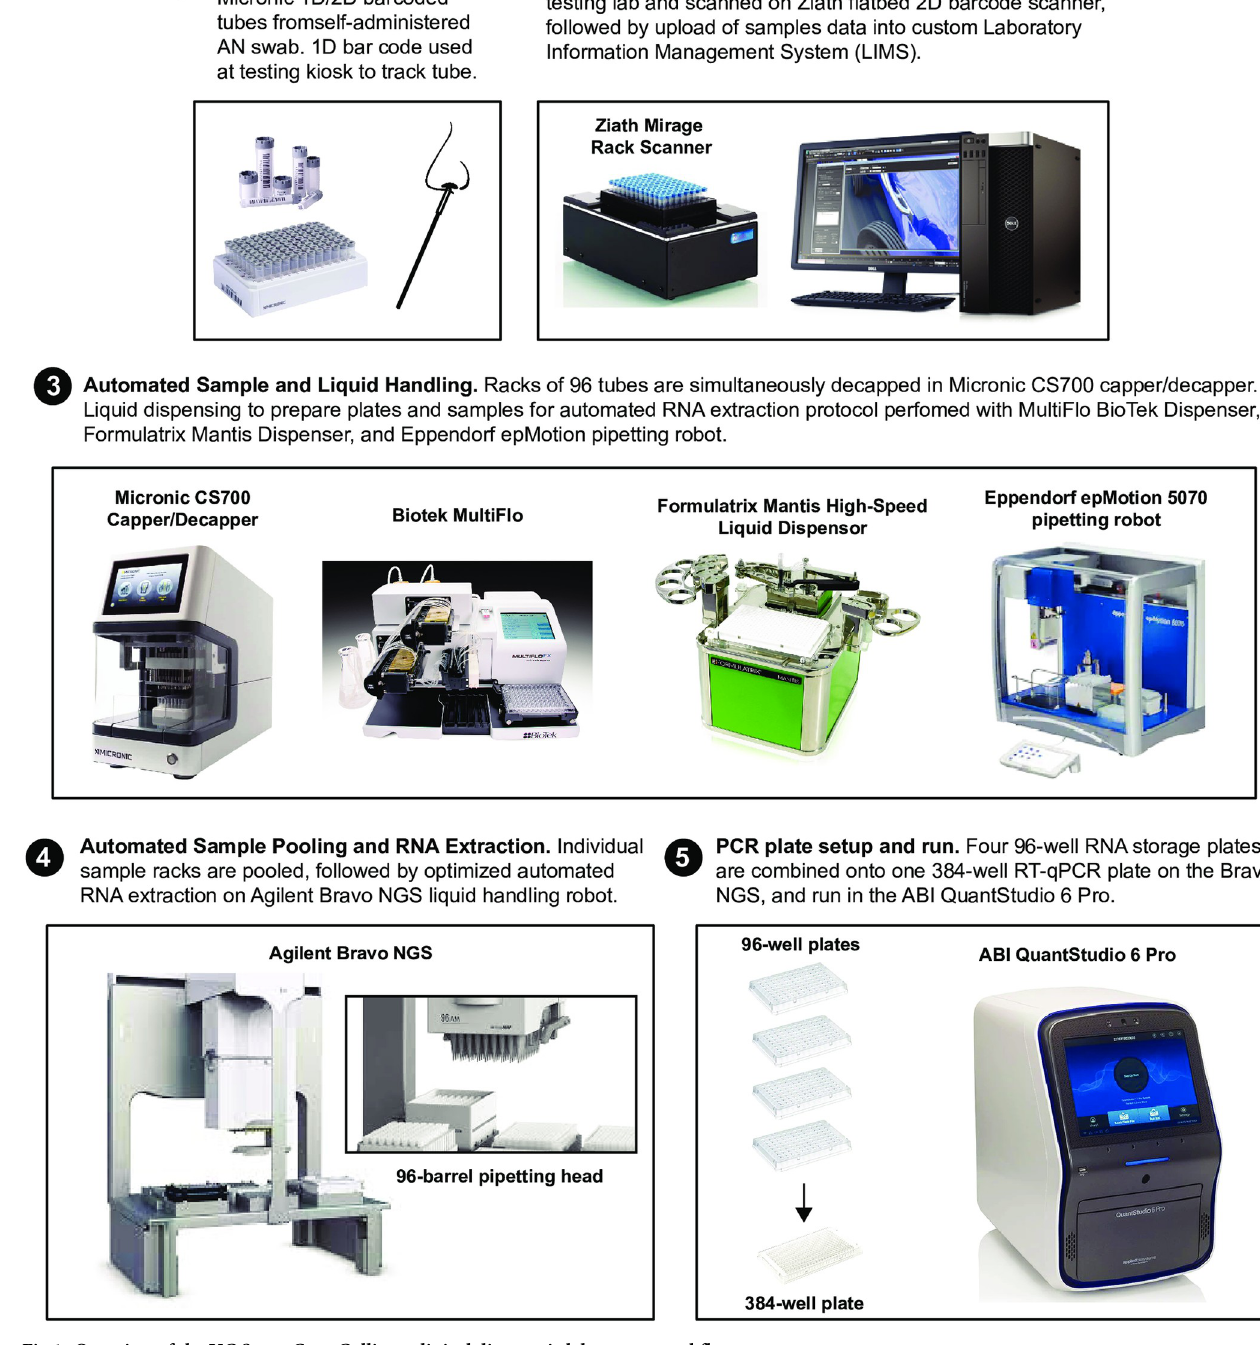
Fig 1. Overview of the UC Santa Cruz Colligan clinical diagnostic laboratory workflow.